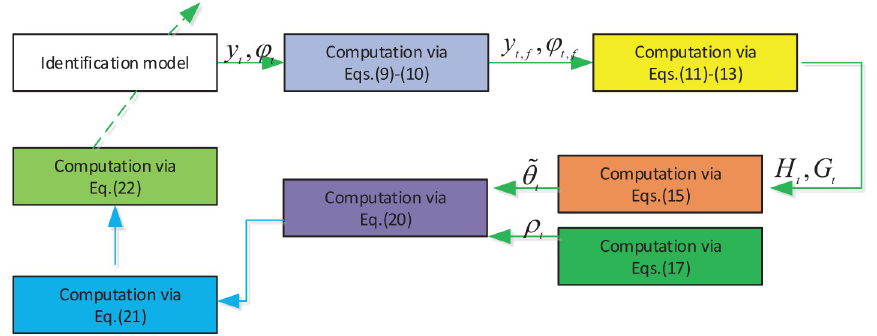
Fig 2. Schematic of sandwich system with proposed